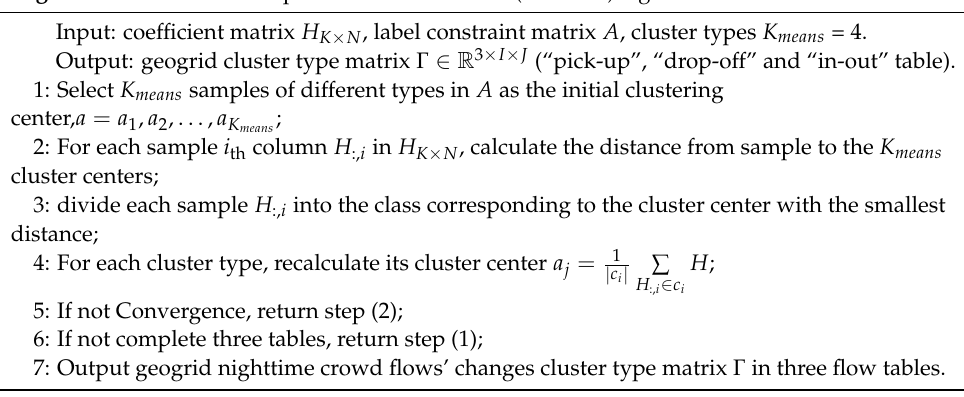
Algorithm 2. Dual Semi-Supervised Convex NMF (DCNMF) algorithm.